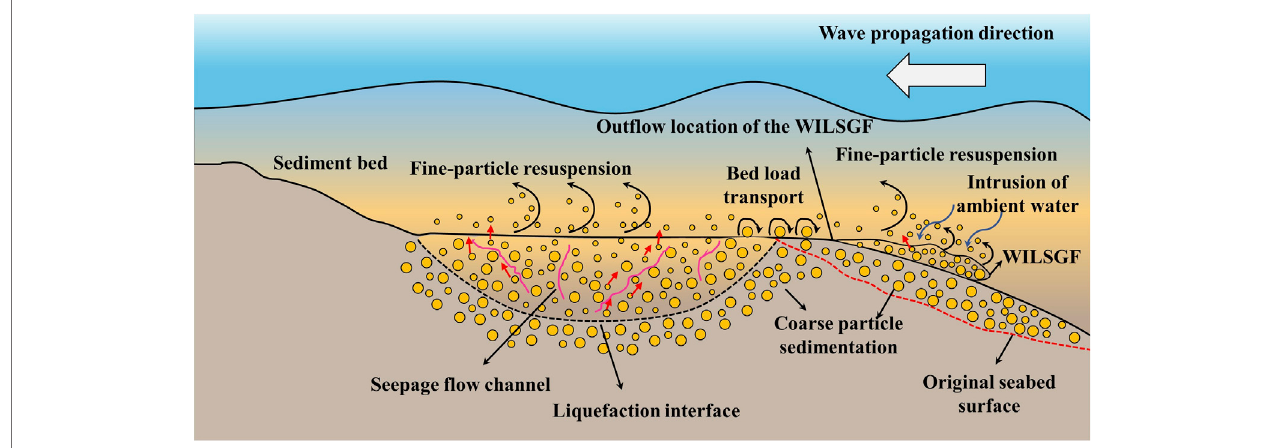
FIGURE 11 | Mechanism of WILSGF forming coarse-grained depositional